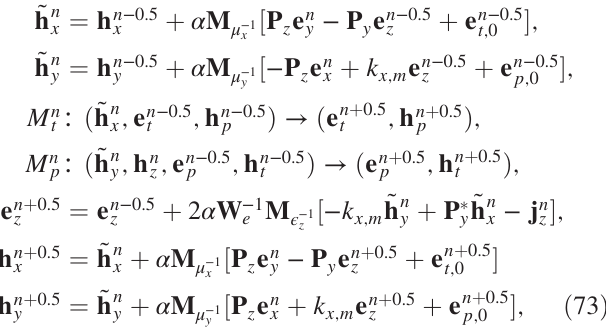
; s Þ (left), and the harmonics m ¼ 1 , 9, 19, of W cc x